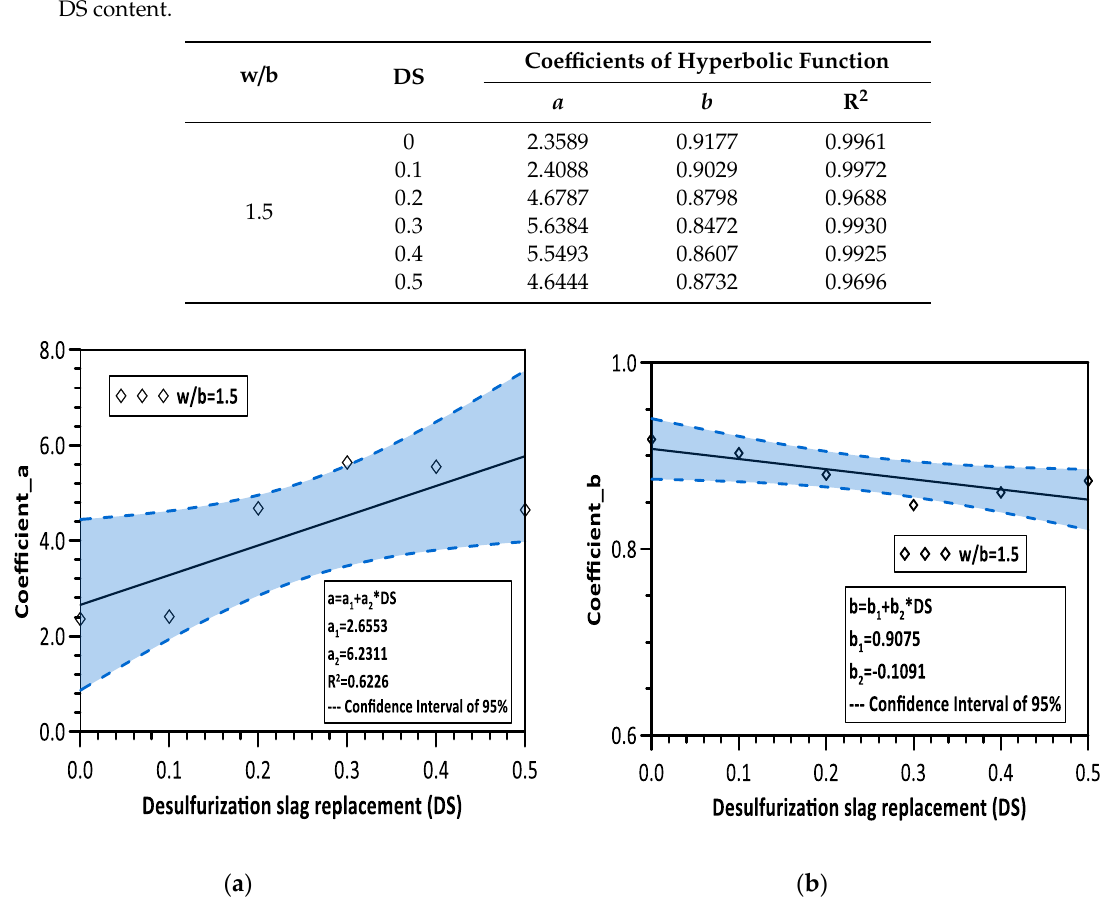
Figure 9. ( a ) The relationship between the hyperbolic function coefficient 𝑎 and the DS content. ( b ) The relationship between the hyperbolic function coefficient 𝑏 and the DS content.